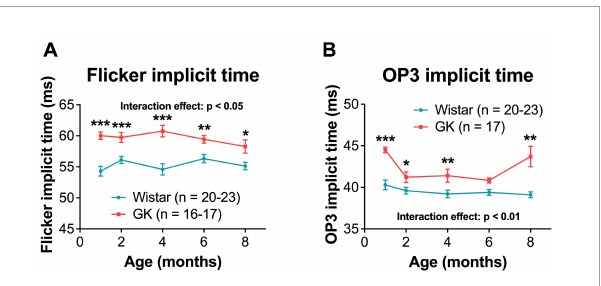
FIGURE3 Goto-Kakizaki rats showed delayed OP and flicker implicit times, beginning at 1 month and persisting until 8 months. Quantification of flicker (A) and OP3 ( B , 0.7 log cd s/m 2 ) implicit times at 1, 2, 4, 6, and 8 months of age. Black asterisks indicate comparisons between